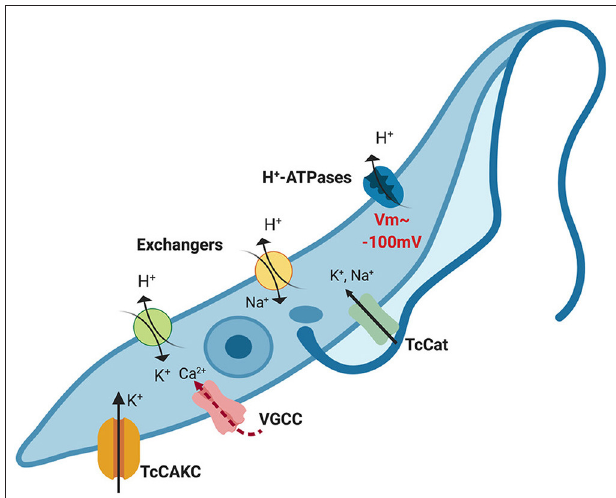
FIGURE 8 | Proposed model of ionic homeostasis in T. cruzi . H + ATPases maintain the gradient of protons that drive the resting membrane potential, which is about − 100mV in epimastigotes. Additionally, Na + /H + and K + /H + exchangers contribute to H + extrusion mobilizing other monovalent ions. Intracellular potassium concentration is balanced through the combined action of channels and exchangers. Given the negative membrane potential beyond the theoretical equilibrium potential for K + ( ∼ 80mV), activation of TcCAKC can mediate K + efflux until the membrane potential reaches values higher than the equilibrium potential, when the electrochemical gradient will drive K + out of the cells. Depolarization of the membrane could then activate voltage-gated calcium channels (VGCC), responsible for oscillations of the intracellular Ca 2 + concentration. For simplicity purposes, in this model we have omitted PMCA and SERCA-like pumps that participate in intracellular calcium